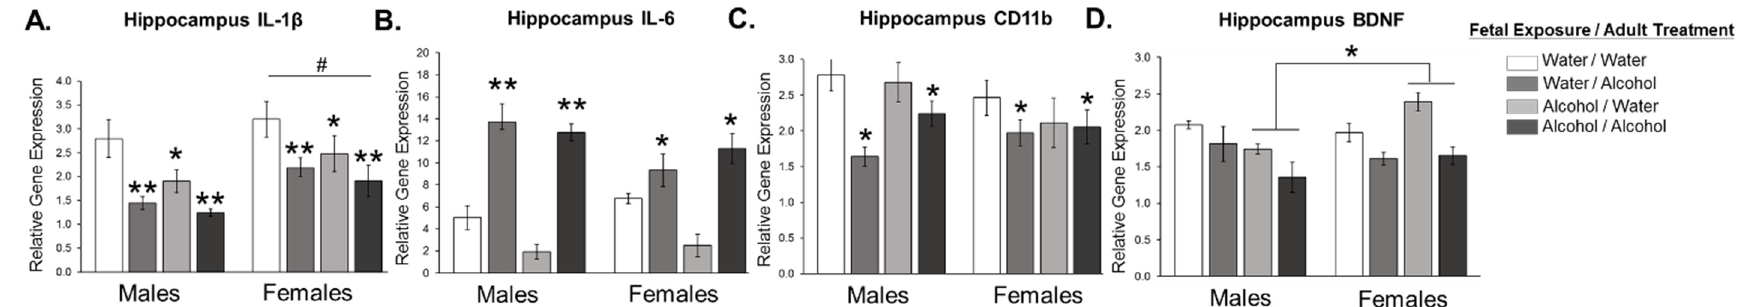
Figure 2. Hippocampal gene expression in male and female rats exposed to alcohol during fetal development, adulthood, or both. Pregnant dams were treated with alcohol or water on E10-16 (2 g/kg, 2 × /day). Offspring were allowed to grow up undisturbed at which point they were treated with either an acute dose of alcohol (4.5 g/kg, 2 × ) or water. Brain tissue was collected 2 h after the last dose of alcohol for the analysis of various cytokines and Brain Derived Neurotrophic Factor (BDNF). ( A ) Analysis of IL-1 β mRNA revealed a significant main effect of sex ( F 1,50 = 6.273; # p = 0.016), prenatal alcohol exposure ( F 1,50 = 8.971; p = 0.005), and adulthood alcohol treatment (F 1,50 = 17.292; p < 0.001). The * indicate the main effect of prenatal alcohol exposure and the ** indicates p < 0.05, revealing the additive effect of both the prenatal and adult alcohol exposures relative to water treated controls and alcohol/water treated rats. ( B ) Analysis of IL-6 mRNA revealed a significant interaction of sex and adult alcohol treatment ( F 1,50 = 4.772; p = 0.034) * p < 0.05 indicating these males had significantly more IL-6 expression relative to untreated and alcohol/water treated rats. ** p < 0.05 indicating that these alcohol treated females had significantly higher levels of IL-6 relative to all other groups. ( C ) Analysis of CD11b mRNA revealed a significant main effect of adult alcohol treatment ( F 1,50 = 7.197; * p = 0.010 relative to adult water treated rats).( D ) Analysis of BDNF mRNA in the hippocampus revealed a significant interaction between sex and prenatal alcohol exposure ( F 1,50 = 10.594; p = 0.002), * p < 0.05 compared to male rats exposed to alcohol prenatally.